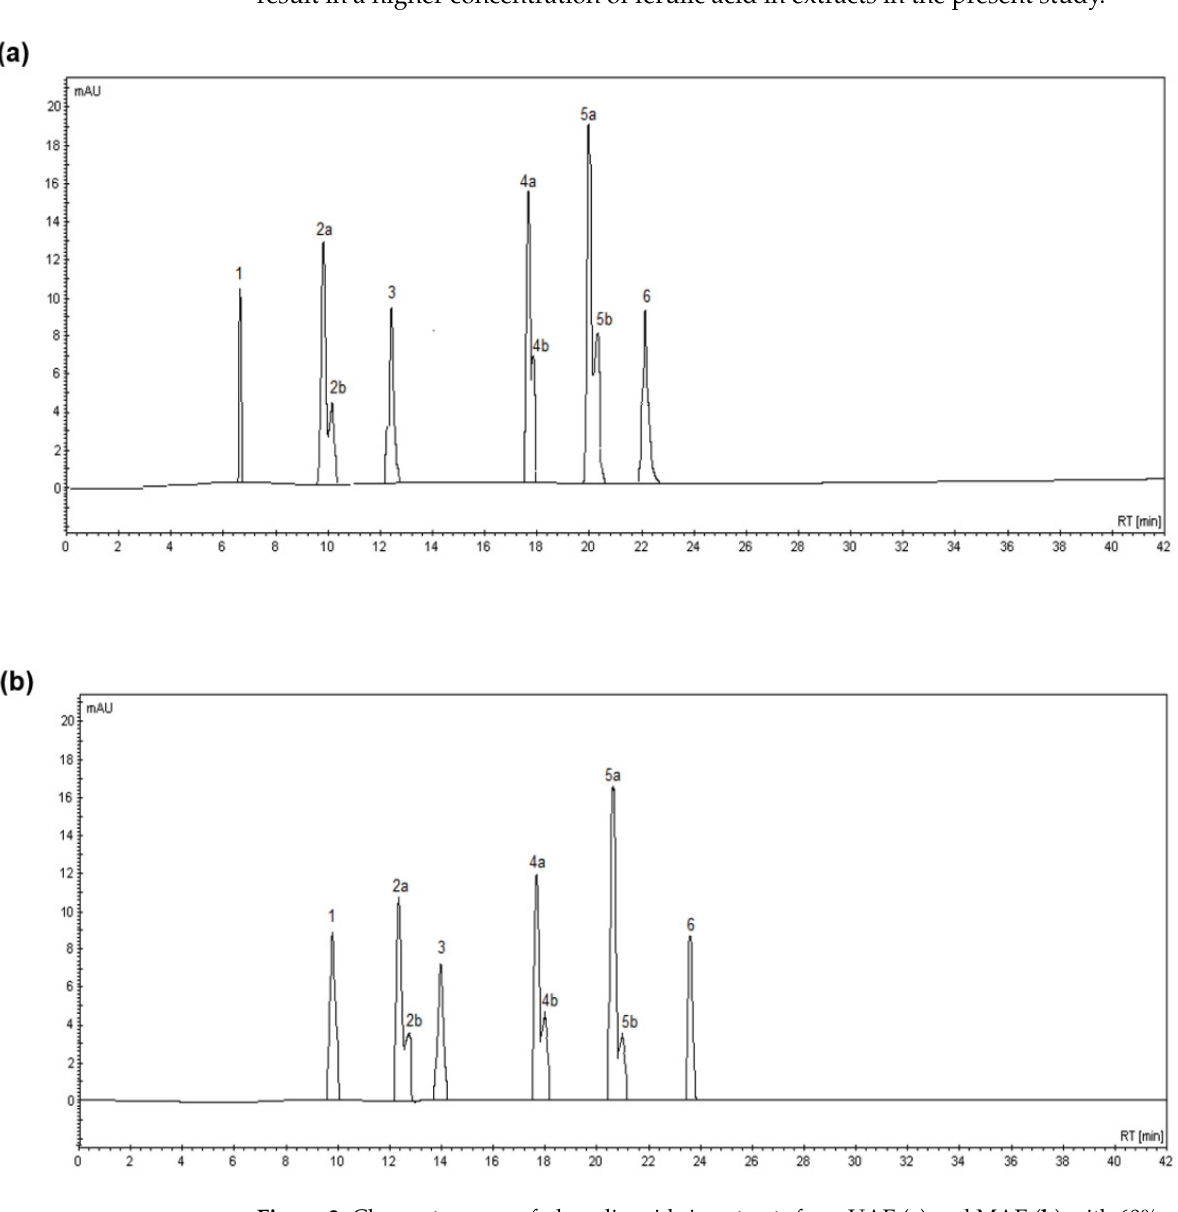
Figure 3. Chromatograms of phenolic acids in extracts from UAE ( a ) and MAE ( b ) with 60% acetone at a solid-to-solvent ratio of 1:15 ( w : v ). Peaks: ( 1 ) p-OH benzoic acid; ( 2a ) vanillic acid; ( 2b ) oxidized vanillic acid; ( 3 ) syringic acid; ( 4a ) p-coumaric acid; ( 4b ) oxidized p-coumaric acid; ( 5a ) ferulic acid; ( 5b ) oxidized ferulic acid; and ( 6 ) sinapic acid.